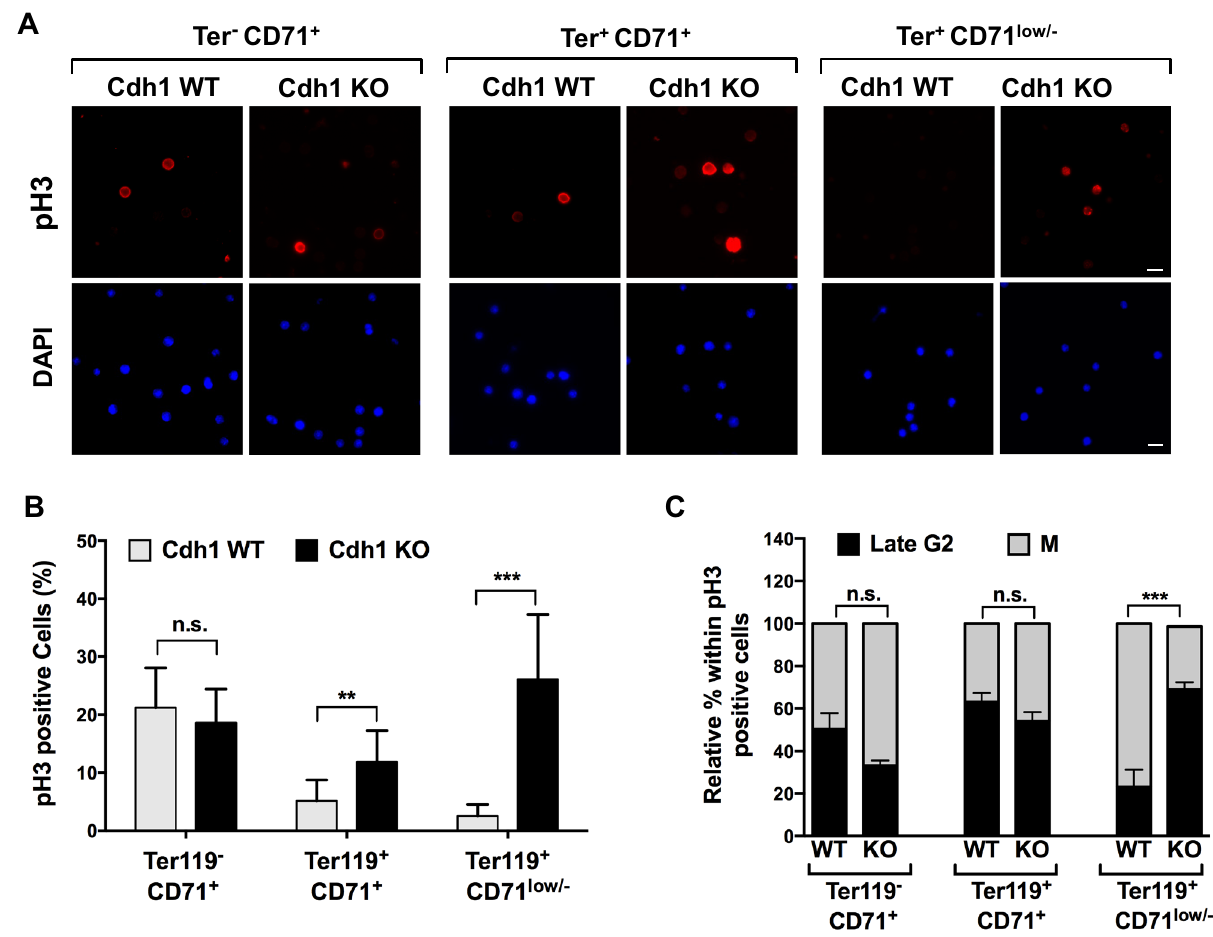
Figure 5. Increased presence of pH3 positive cells in maturing erythroblasts devoid of Cdh1. ( A ) The indicated proerythroblasts and erythroblast populations from E17.5 fetal livers were sorted, and expression of phospho-Histone H3 (pH3) was analyzed by immunofluorescence microscopy. Representative pictures are shown. Scale bar: 10 µm. ( B ) pH3 positive cells were quantified for both genotypes and the results of two independent experiments are summarized in the column graph. At least 950 cells of each genotype were scored in Ter119 - CD71 + and Ter119 + CD71 + populations, and at least 600 of each genotype were scored in Ter119 + CD71 low/- populations. ( C ) Within the pH3 positive cells in the indicated populations, the relative ratio of spotted (late G2) or bright and diffuse (mitosis, M) staining pattern was determined for both genotypes and plotted as stacked bars. Error bars represent s.e.m. ** P < 0.01, *** P < 0.001, ns (not significant) P >